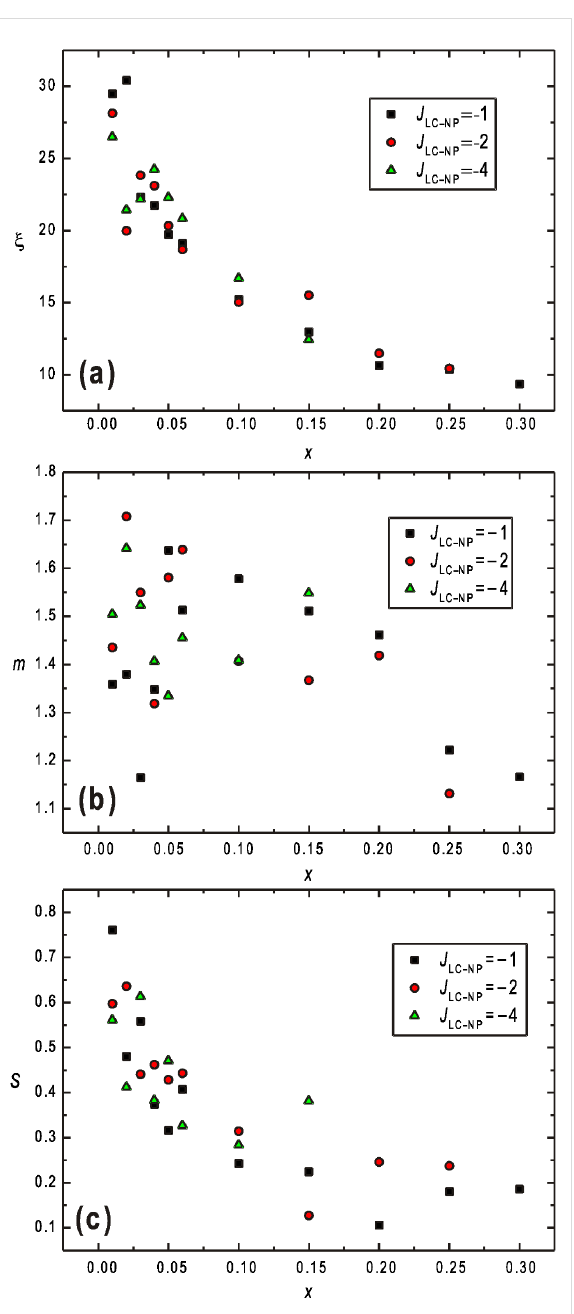
Figure 2: (a) The nematic domain length ξ , (b) the domain dispersion parameter m , and (c) the range parameter s as a function of x for different values of J LC–NP : − 1, − 2, and − 4; J LC–LC = J LC–NP = 1, N = 80 × 80 ×